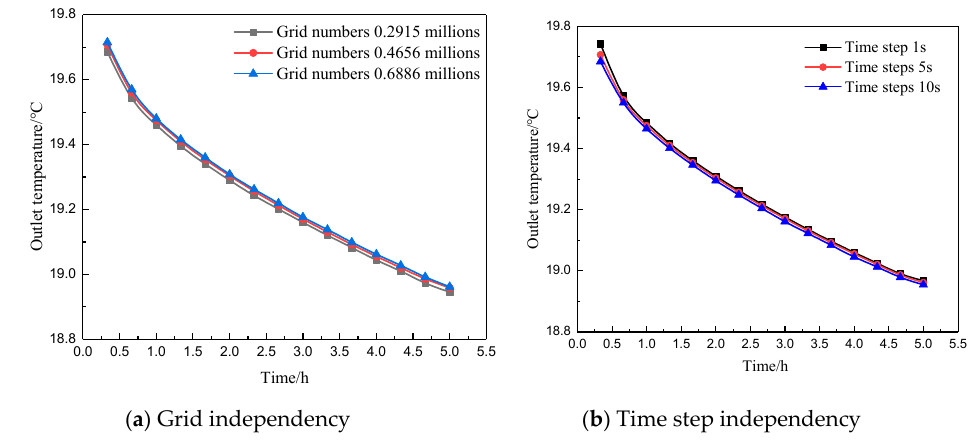
Figure 9. The grid and time step independence for the heat release process.